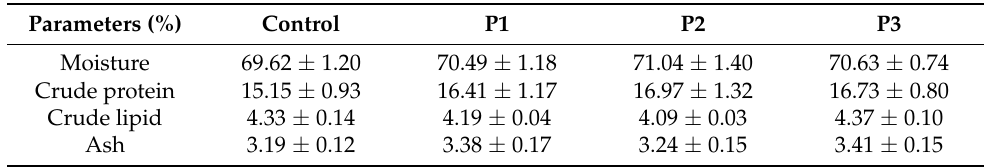
Table 4. Body compositions of rainbow trout fed four experimental diets with different inclusion